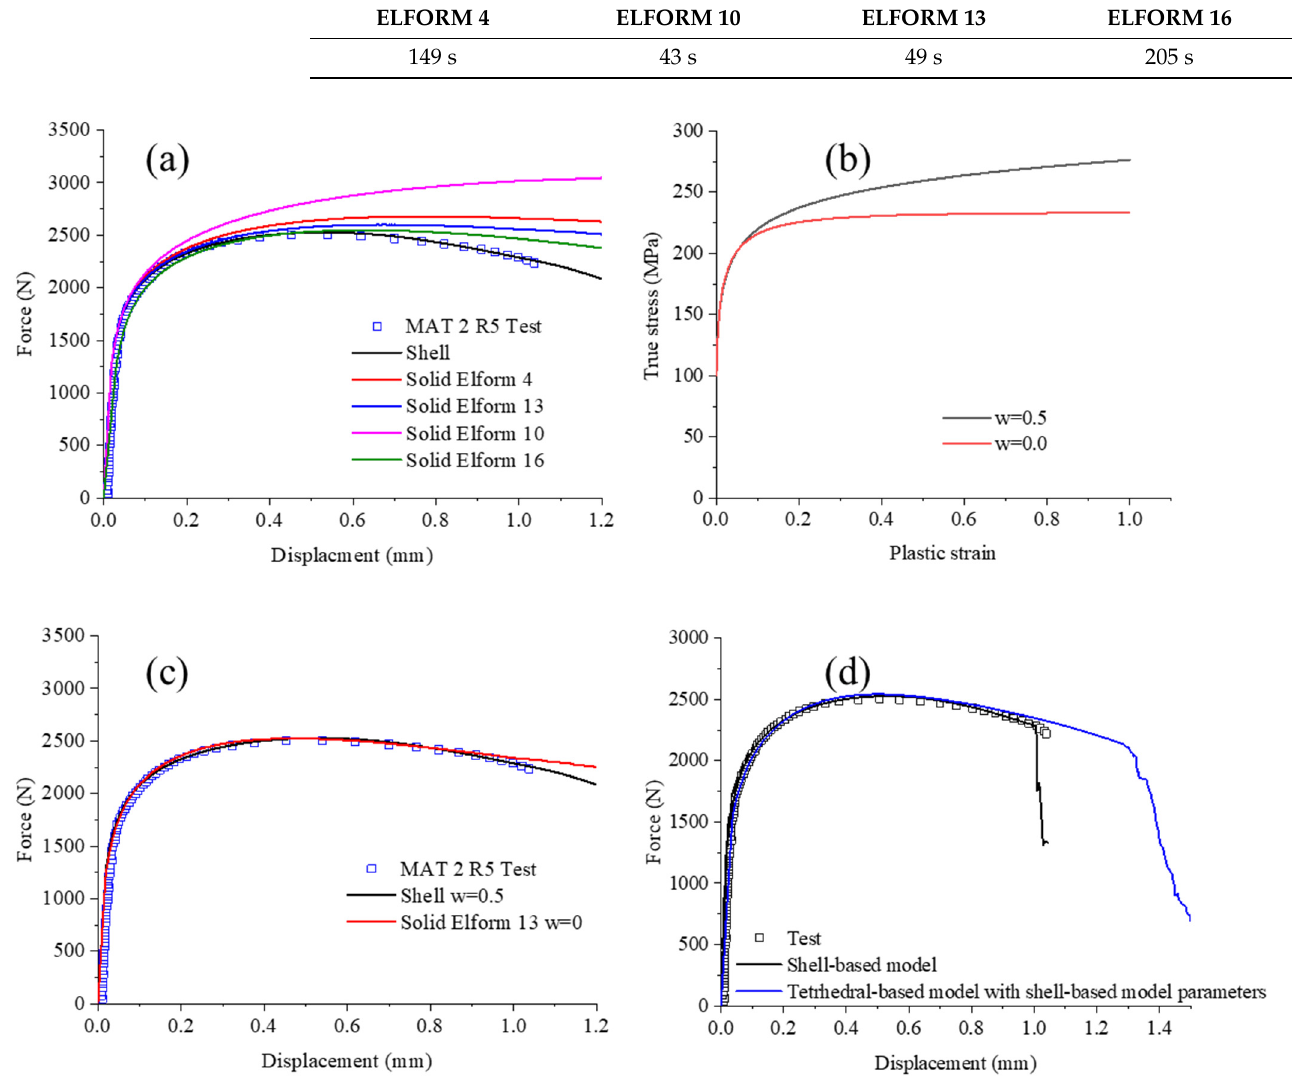
Table 3. CPU times for tetrahedral element models (R13.0 MPP with Intel ® Xeon ® E5-2687W).